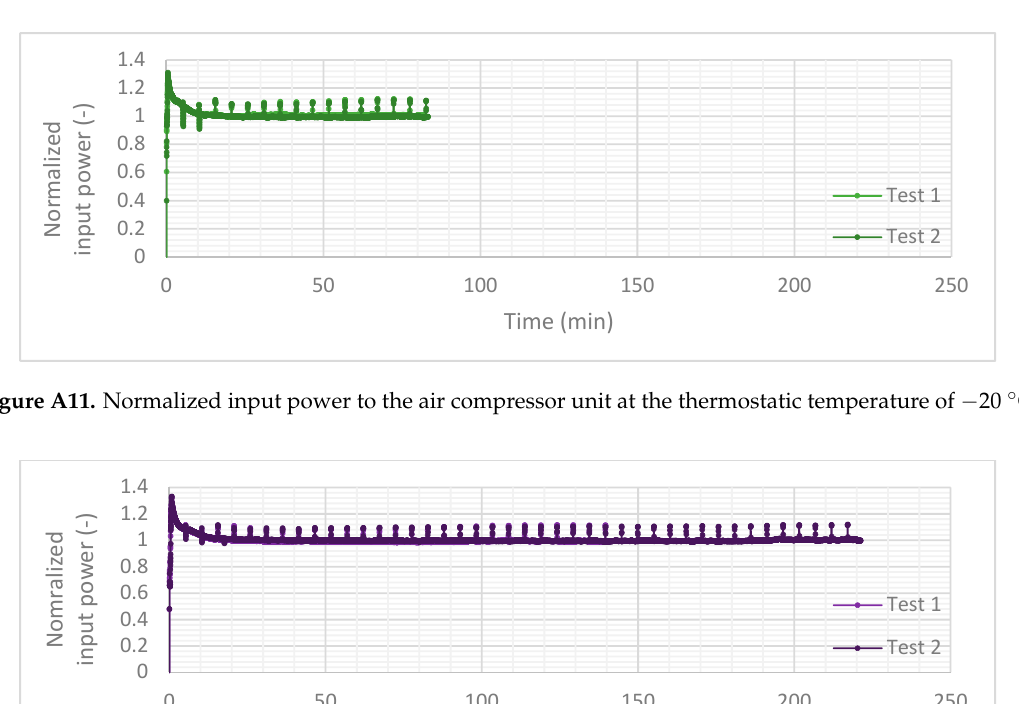
Figure A10. Normalized input power to the air compressor unit at the thermostatic temperature of − 10 °C.